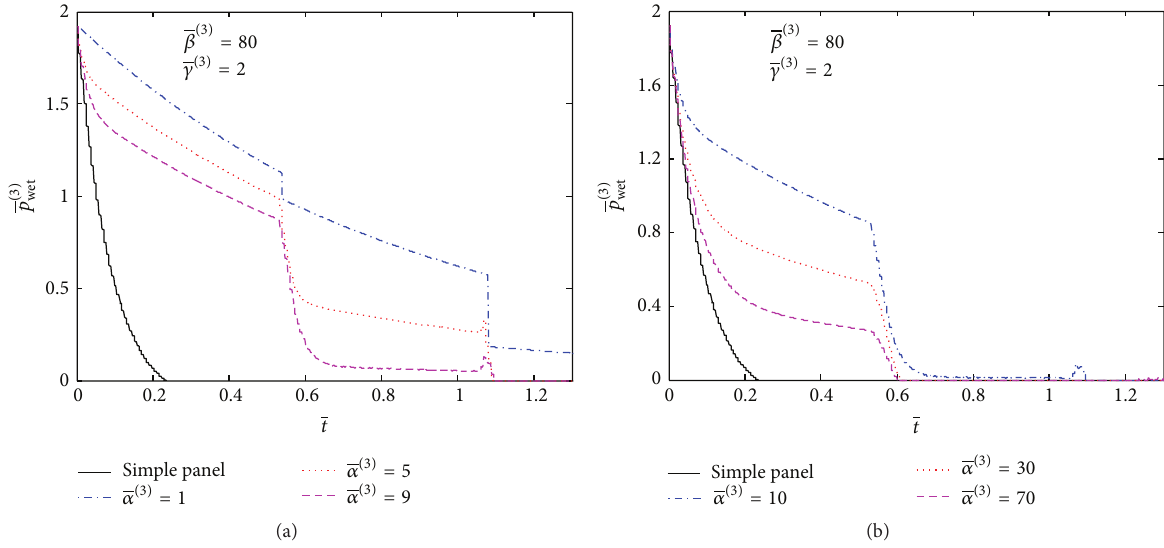
(3) wet for the panel with girder (I-shaped) with the parameter zone (3) = 80 , and 𝛾 (3) = 2